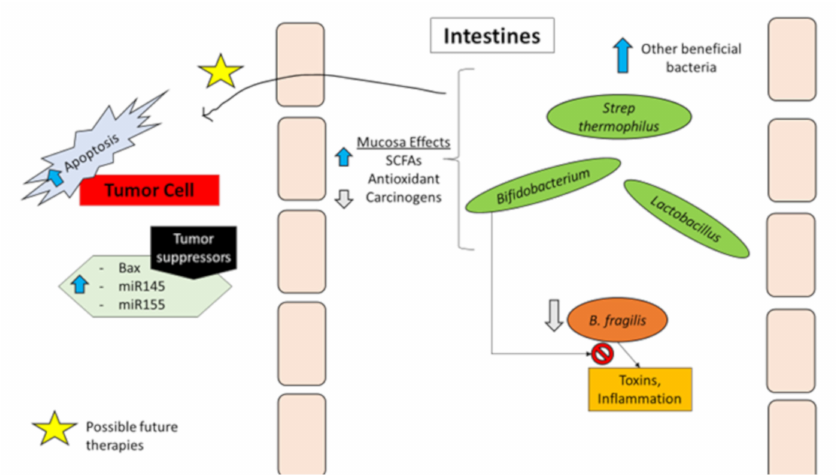
Figure 1. Mechanisms of probiotics. Probiotics increase other beneficial bacteria, while decreasing pathogenic bacteria and their harmful mechanisms. They have also been shown to increase short chain fattyacids(SCFAs)andantioxidants, whilealsodecreasingcarcinogensintheintestines. Possible actions that probiotics have are to increase tumor cell apoptosis and increase in tumor suppressor genes; these may be possible areas to research further into for colorectal cancer (CRC) prevention and adjuvant